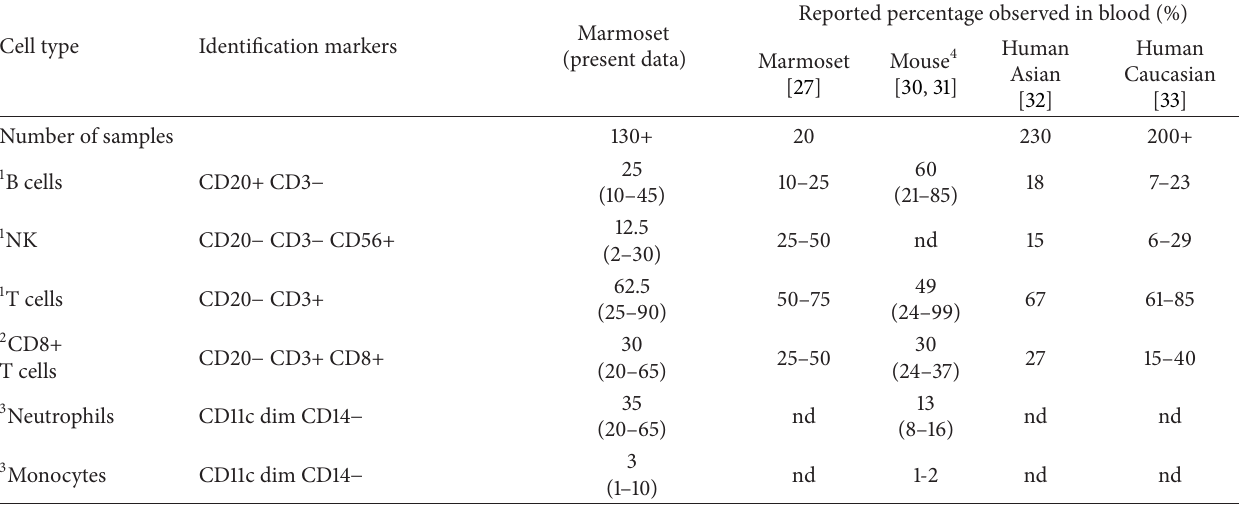
Table 1: Comparison of the percentages of different cell types observed in the blood from healthy marmosets, mice, and humans.